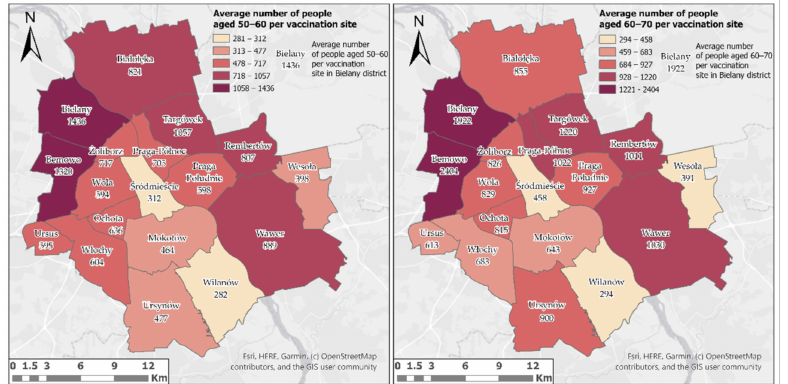
Figure 9. Average number of people in both analysed age groups per vaccination site in districts of